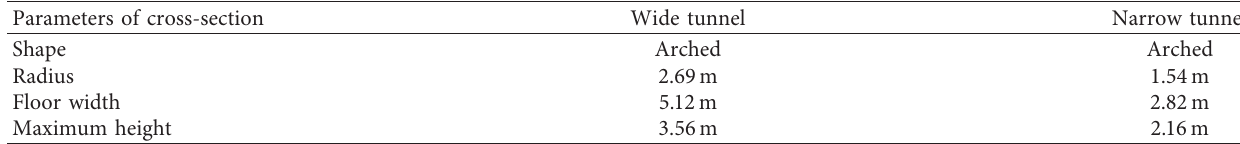
Figure 2: Measurement configuration. (a) Inside views of the tunnels. (b) Diagram of the measurement setup reported in [13]. (c) Details of LoRa nodes. Table 3: Experimental settings: parameters of the measure tunnel.